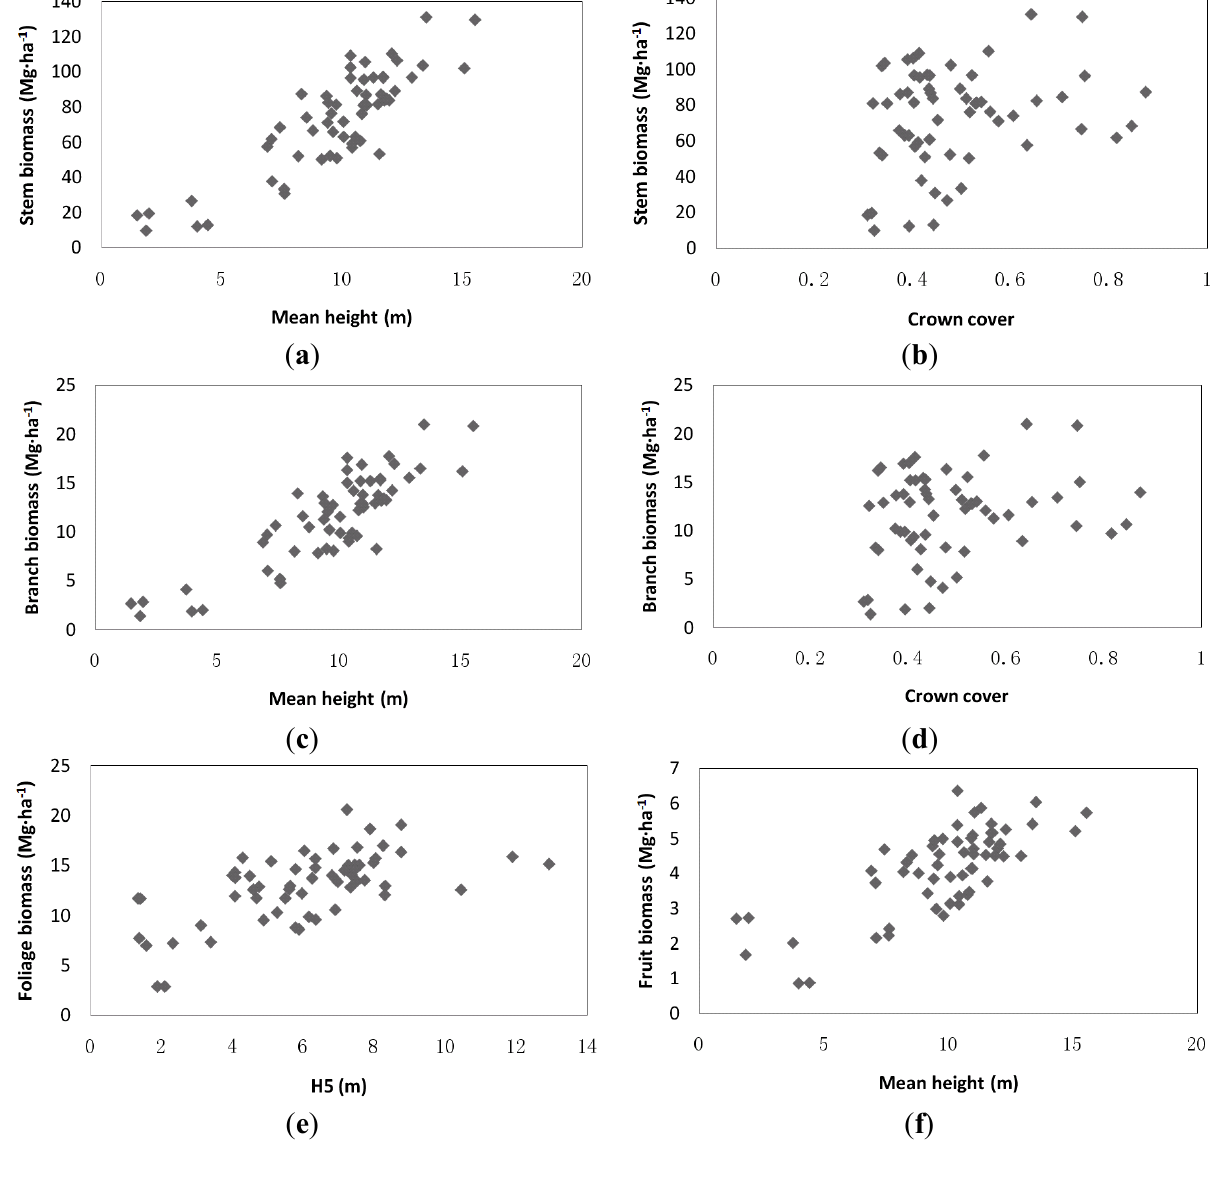
Figure 3. Scatter plots of between above-ground biomass and biomass components and their significant variables. ( a ) and ( b ) compare stem biomass against mean height and crown cover, respectively; ( c ) and ( d ) plot branch biomass against mean height and crown cover, respectively; ( e ) is plots foliage biomass against H5; ( f ) and ( g ) plot fruit biomass against mean height and H85, respectively; ( h ), ( i ) and ( j ) plot crown biomass against mean height, H85, and crown cover, respectively; ( k ) and ( l ) plot above-ground biomass against mean height and crown cover,